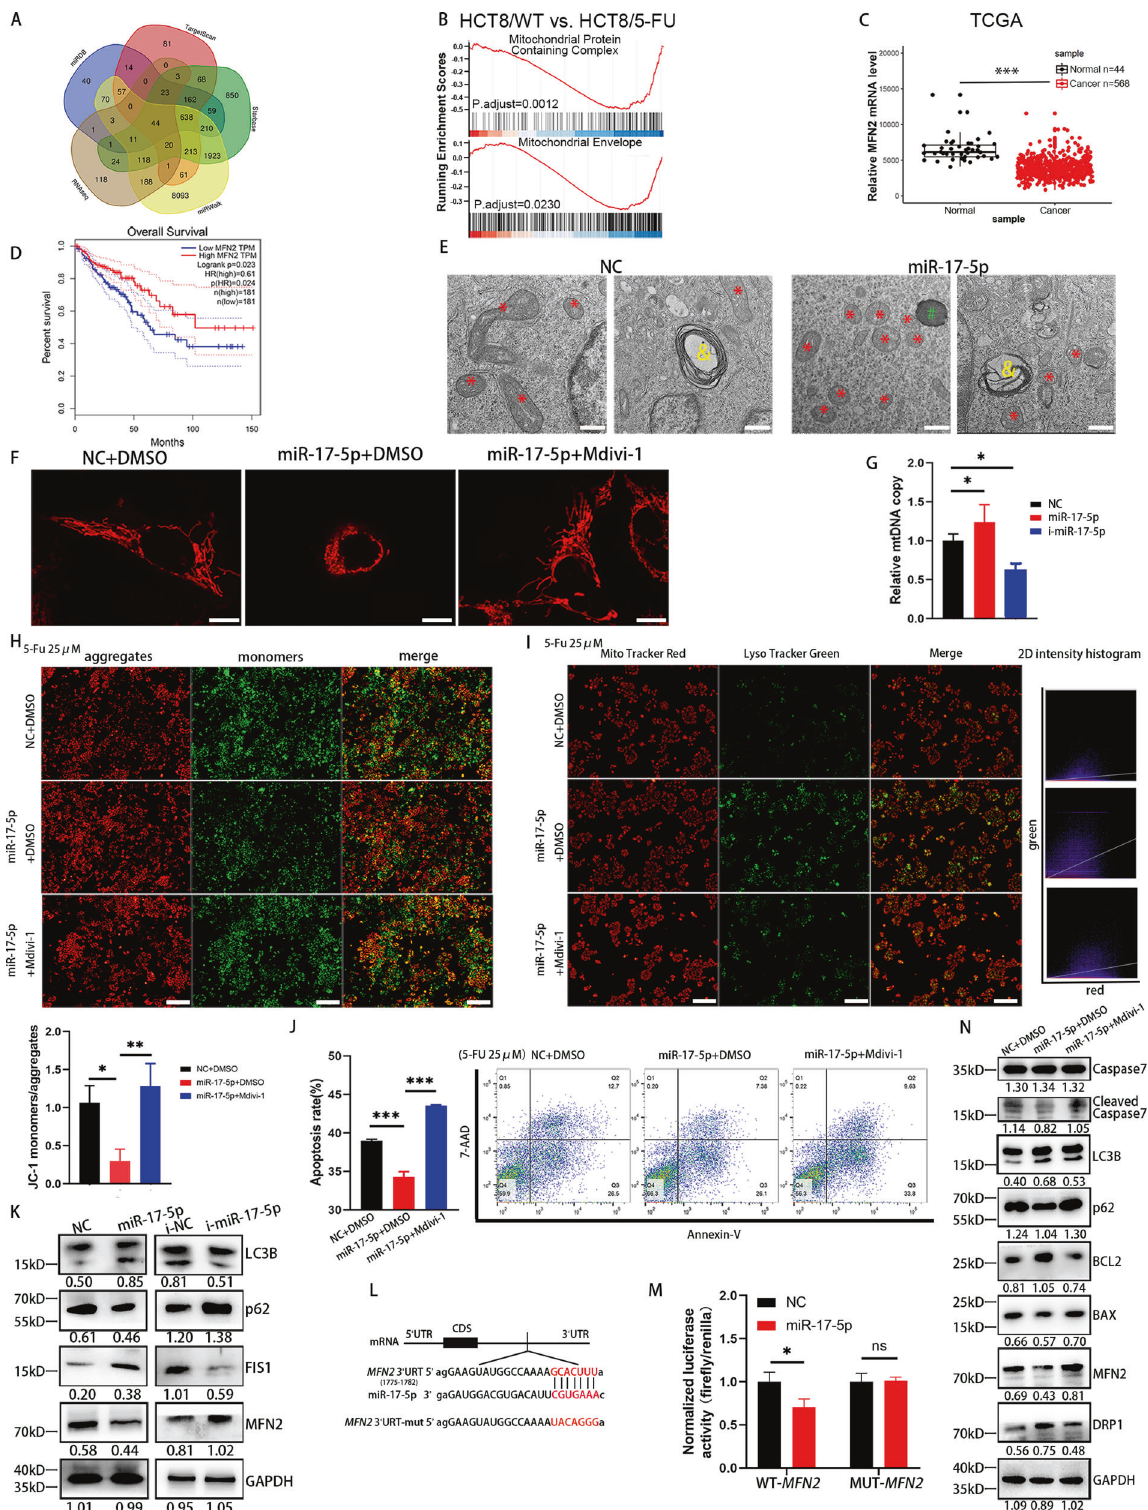
changes in the mitochondria and autophagosome. As shown in Fig. 2E, the miR-17-5p overexpression group shown a distinctly fragmented mitochondrial morphology compared with the control group, which indicated that miR-17-5p increased fi ssion and decreased mitochondrial fusion. Mdivi-1, an inhibitor